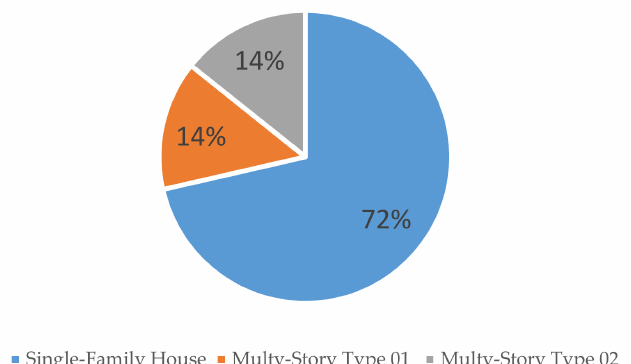
Figure 9. Optimal mix of residential typologies to achieve a Net-Zero Energy